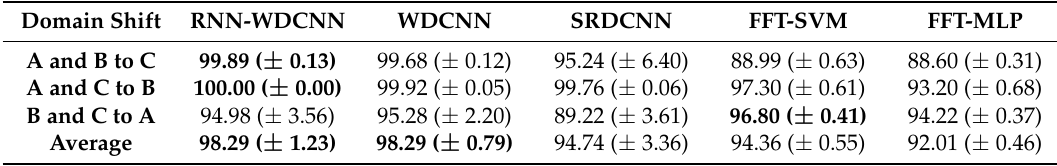
Table 12. F1 scores of the models considered in this work (as a percentage) for the domain adaptation task considered in scenario 2 (best values are highlighted in